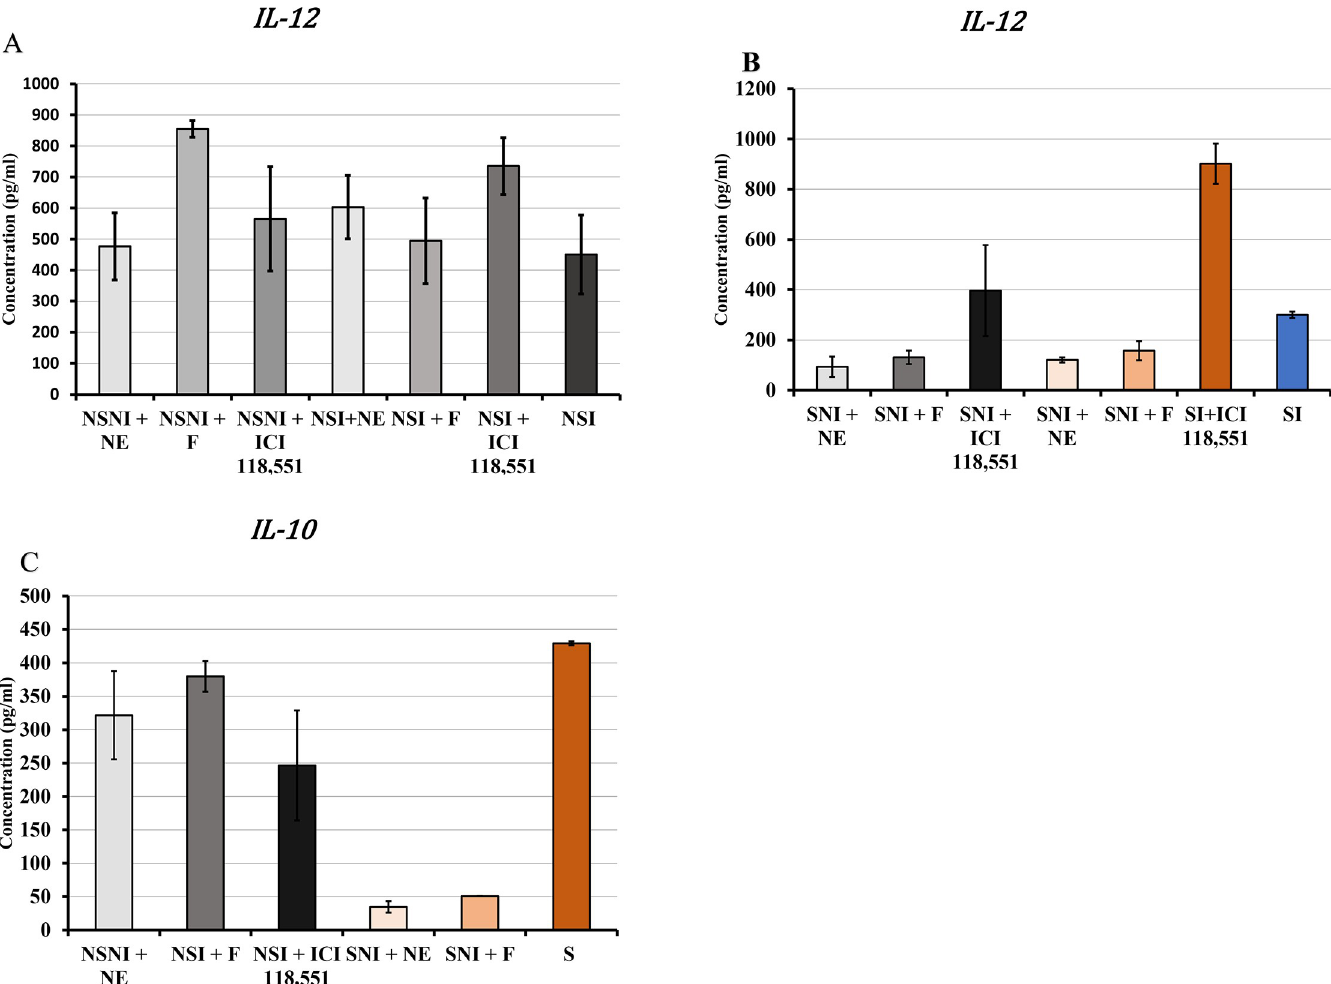
Fig 9. Differential cytokine production of immature BMDCs pre-exposed to NE, Fenoterol, or ICI118,551. A ) non-stressed-non-infected (NSNI) or non-stressed- infected mice(NSI); B, C ) Stressed-non-infected (SNI) or stressed-infected (SI) mice; to NE, Fenoterol (F), or ICI118,551 results in irregular production IL-12 and IL-10 production. Immature dendritic cell culture was pre-exposed to NE (1 μ M), Fenoterol (1 μ M) or ICI 118, (1 μ M) for 1 h before stimulation with LPS (2.5 μ g/mL) for 24 h before RNA isolation. Data shown are a mean +/_ SEM of two or more independent experiments performed on different dates. � Denotes significant statistical differences between treatment groups at the level of (p <